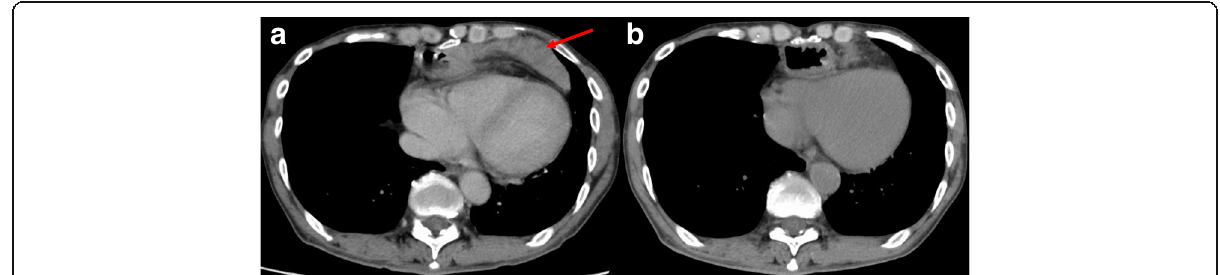
Fig. 3 Computed tomography findings in case 2. a Computed tomography image obtained on the day of symptom onset. The intestine (red